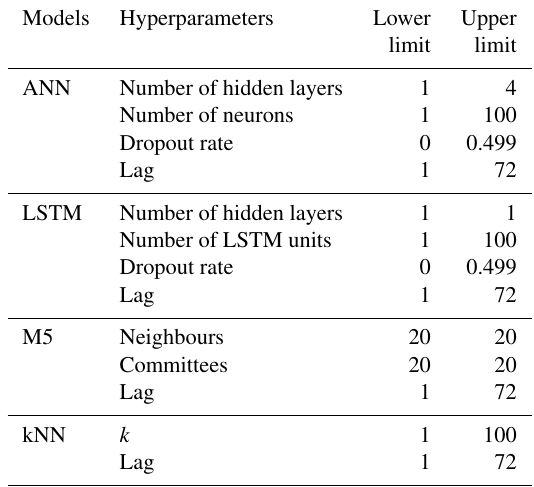
Table 3. Selected ML hyperparameters for tuning.